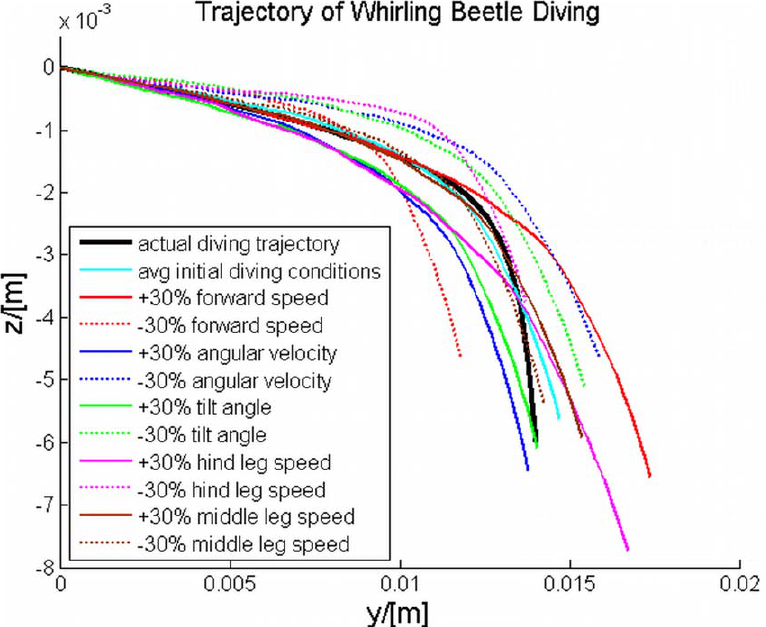
Figure 8. Results from the diving simulations. Simulation results of diving with different initial conditions. The initial values of forward speed (0.17 m/s), angular velocity of the body ( 2 333 u /s), tilt angle of the body (7 u ), striking speed of the hind legs (0.18 m/s), and striking speed of the middle legs (0.14 m/s), were varied 6 30% to determine the effect on the diving trajectory. Each of these terms was varied 6 30%, with the other terms held constant, to determine their effects on the overall trajectory. The values generated the closest diving trajectory as observed in the experimental studies was with an initial speed of 0.17 m/s, angular velocity of 2 333 u /s, tilt angle of 2 7 u , hind leg speed of 0.18 m/s, and middle leg speed of 0.14 m/s.